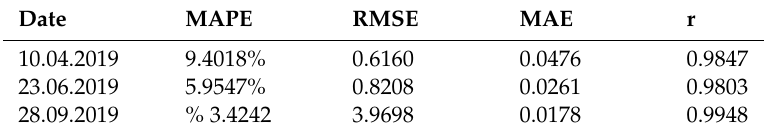
Figure 13. Forecasting and real load curves for 04/02/2019. Table 10. Statistical performance measures for load data.